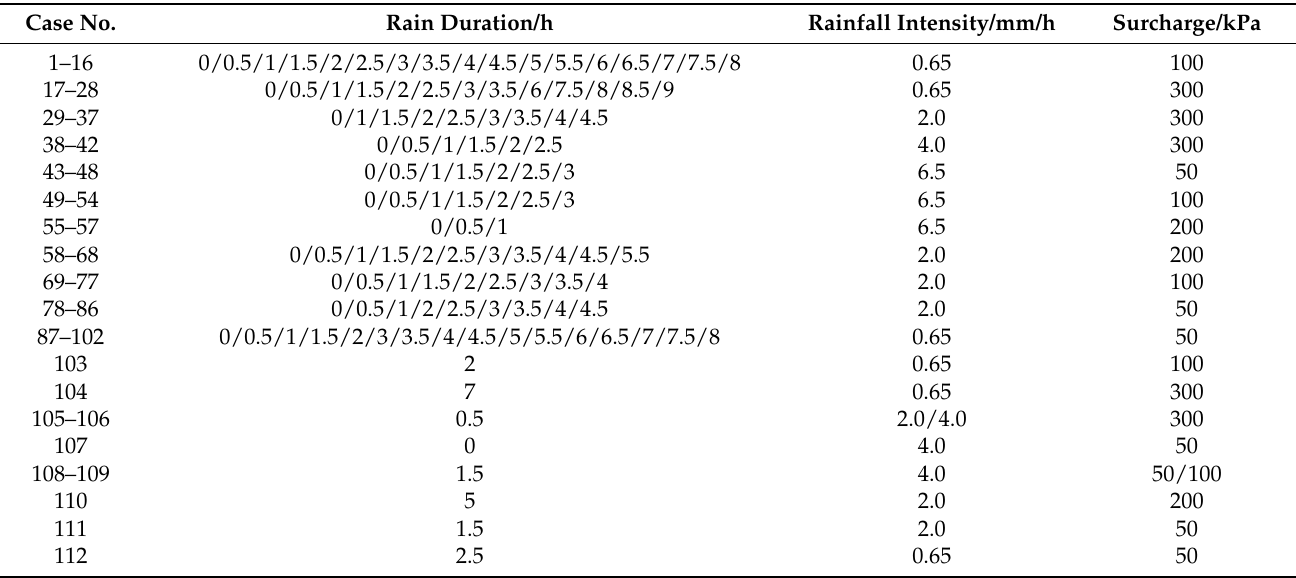
Table 5. Numerical model